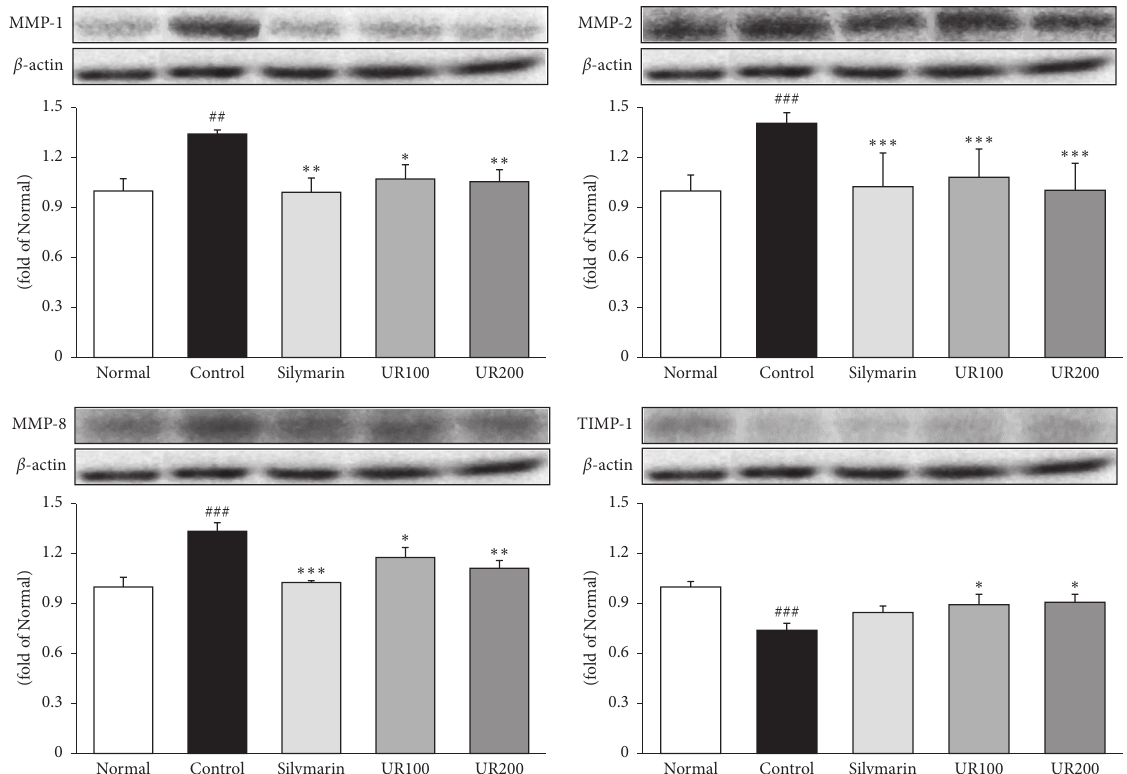
Figure 6: Effect of UR on collagen associated with proteins. Effects of UR on the expression levels of MMP-1, -2, and -8 and TIMP-1 by the Western blotting assay. Data are expressed as the mean ± SEM ( n � 7). Significance: ## p < 0 . 01 and ### p < 0 . 001 vs. the normal group and ∗ p < 0 . 05, ∗∗ p < 0 . 01, and ∗∗∗ p < 0 . 001 vs. the ALI control